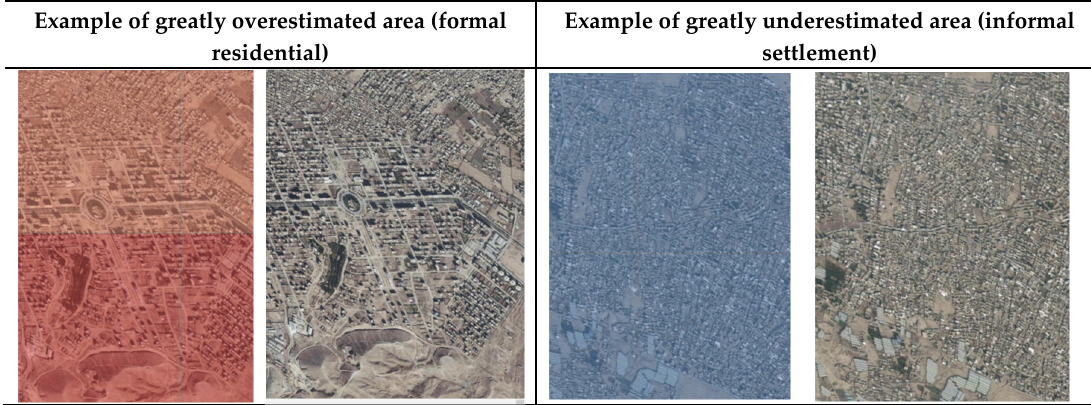
Figure 6. Examples of very greatly over- and underestimated areas in